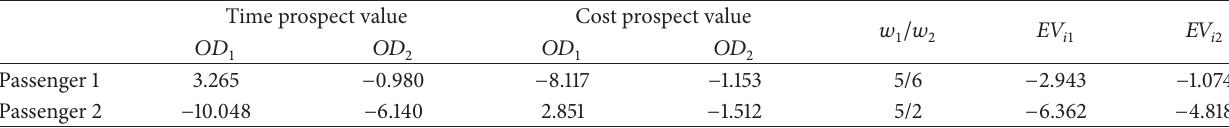
Table 3: Prospect value of scene 1.